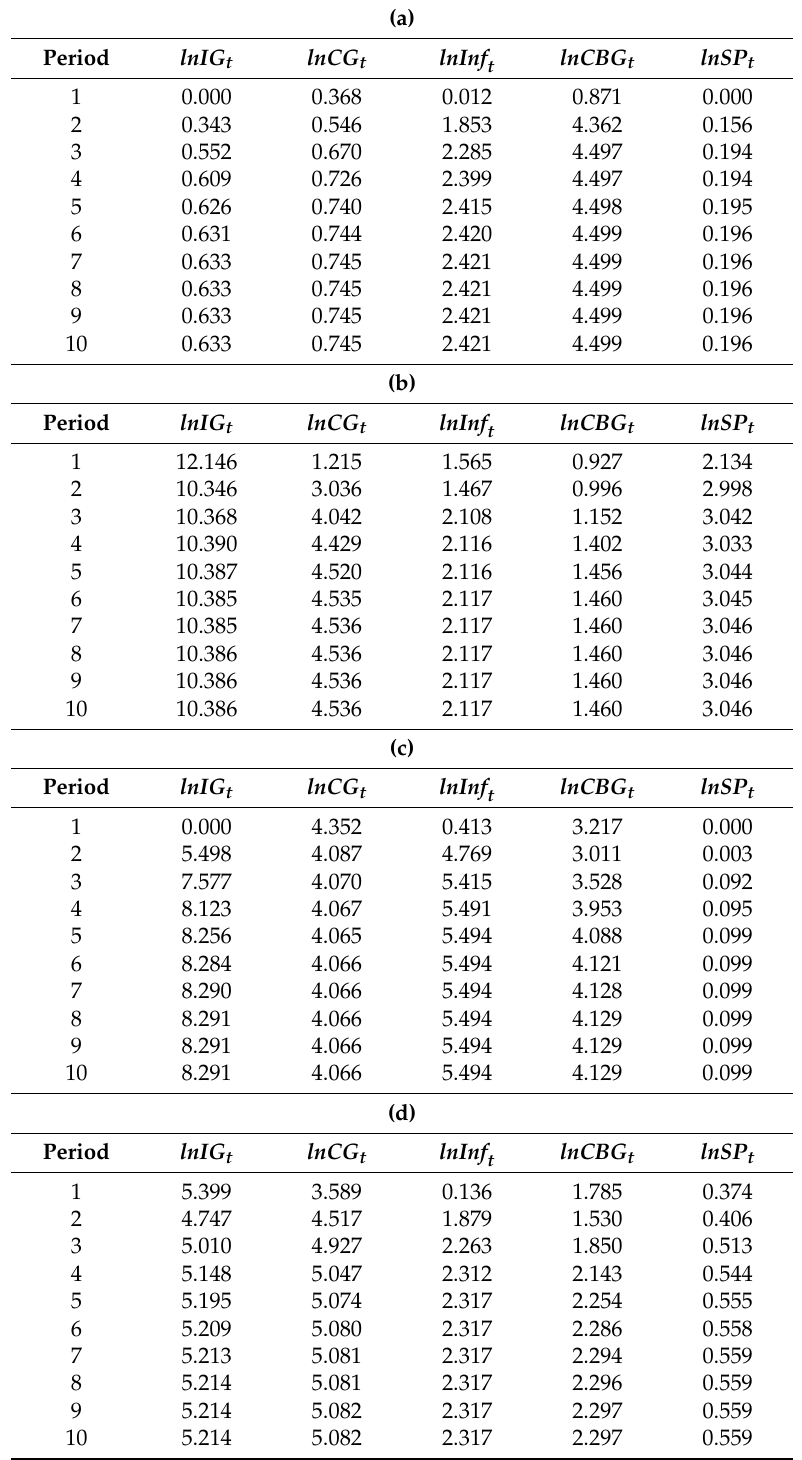
Table 3. China. ( a ) Variance Decomposition of Domestic EPU. ( b ) Variance Decomposition of USA EPU. ( c ) Variance Decomposition of UK EPU. ( d ) Variance Decomposition of Europe